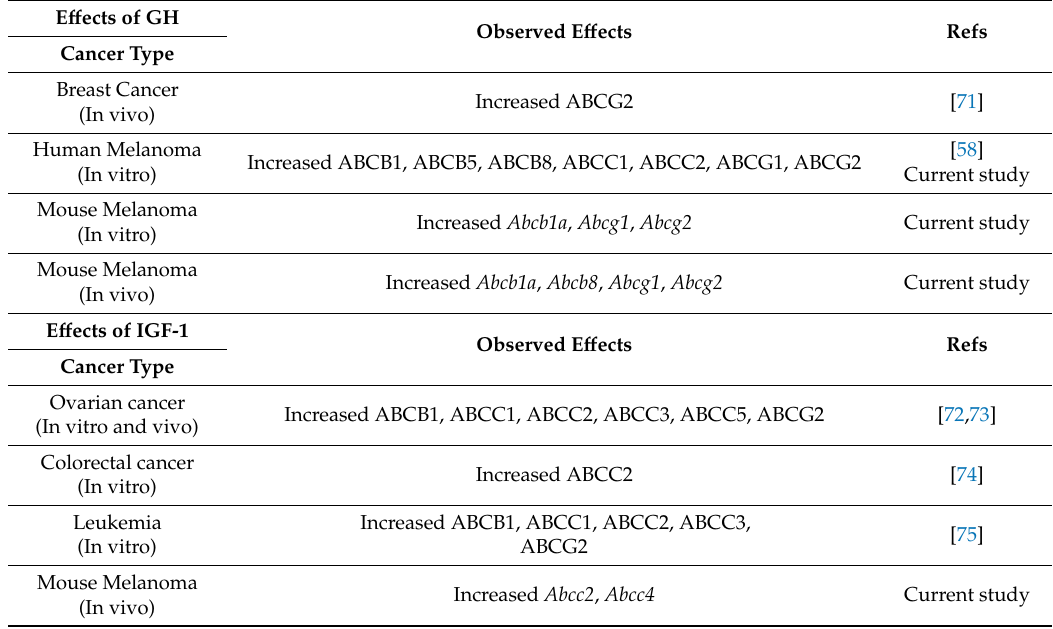
Table 1. Summary of known e ff ects of GH / IGF-1 axis on ABC transporters in di ff erent cancers. E ff ects of